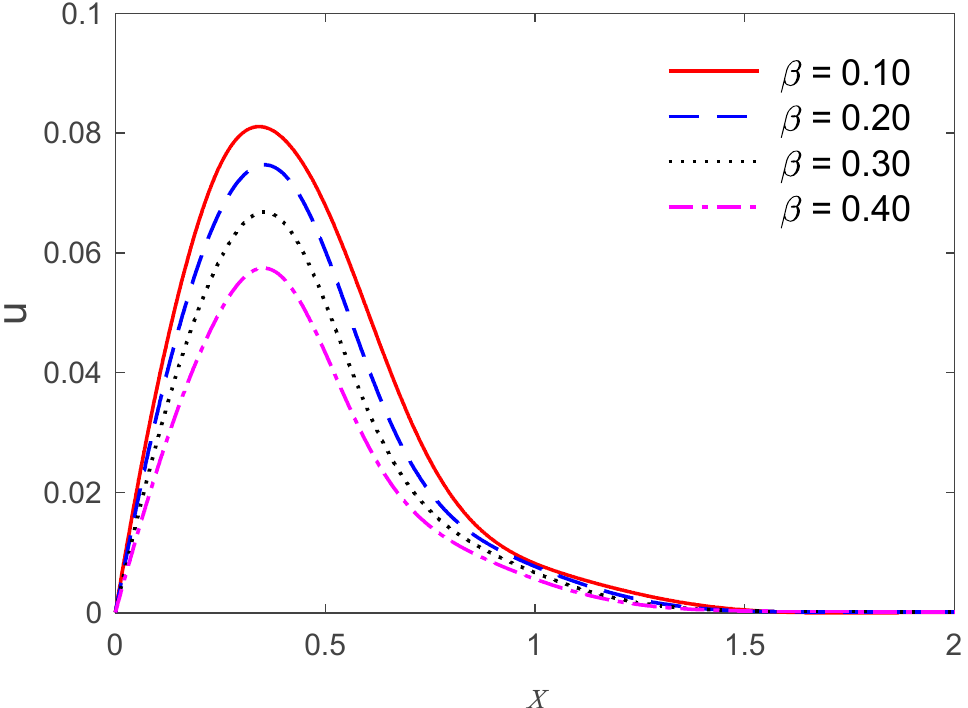
Figure 10. The effects of porosity on the solid displacement variations.